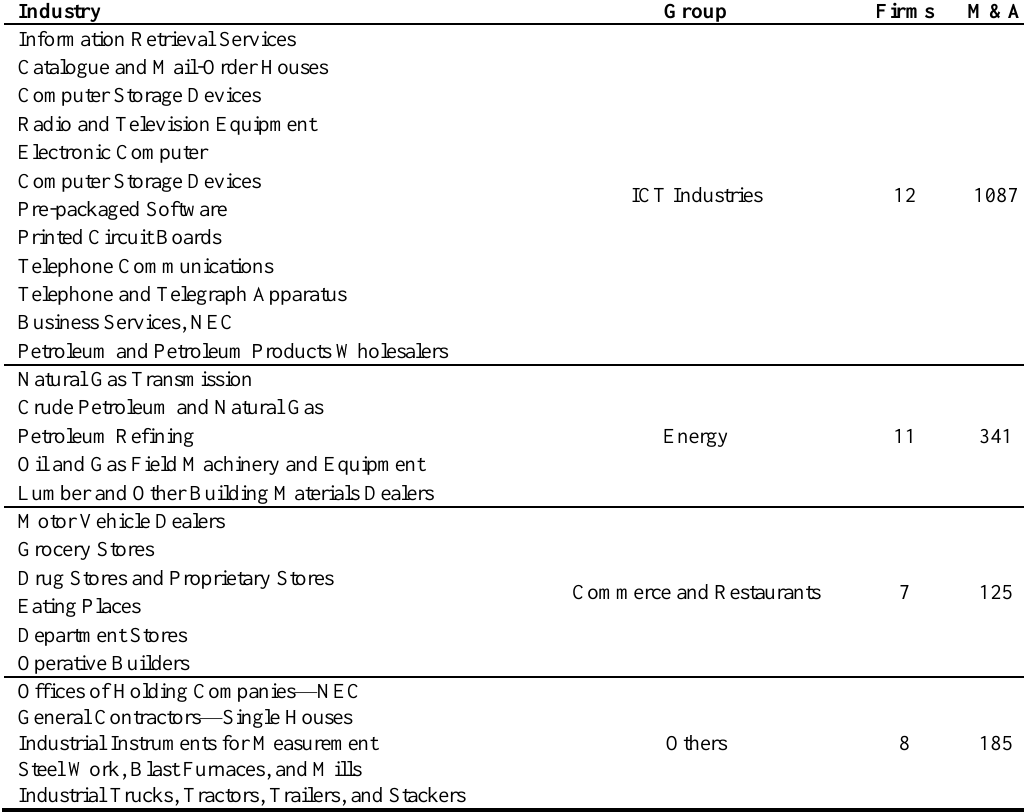
Table 2: Firms and Mergers Grouped by Main